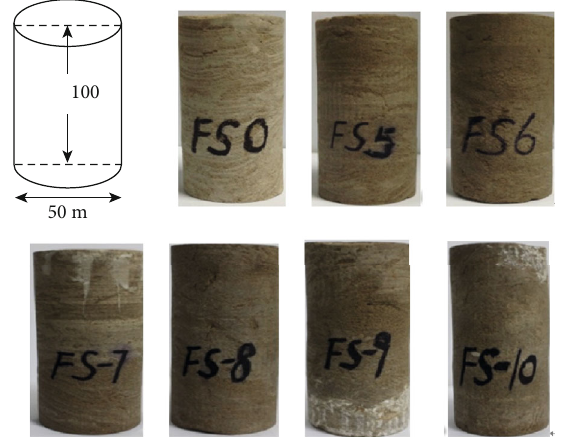
Figure 21: Strength softening test siltstone